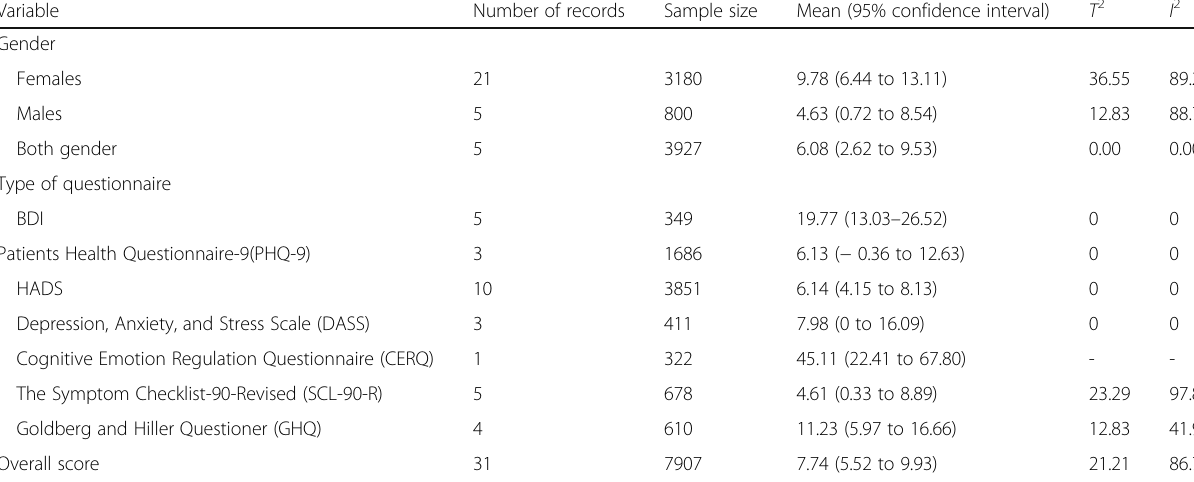
Table 4 The pooled and subgroups of depression scores among Iranian couples Variable Number of records Sample